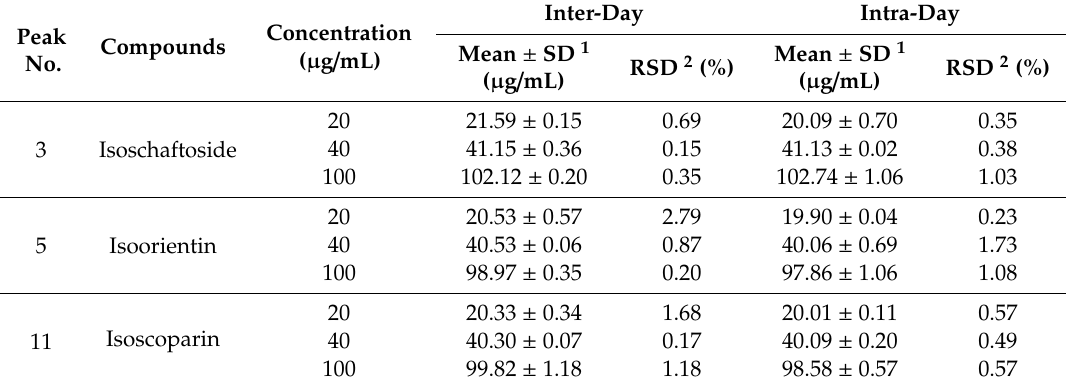
Table 3. Intra- and inter-day precisions of the three representative flavonoids identified from the wheat sprout